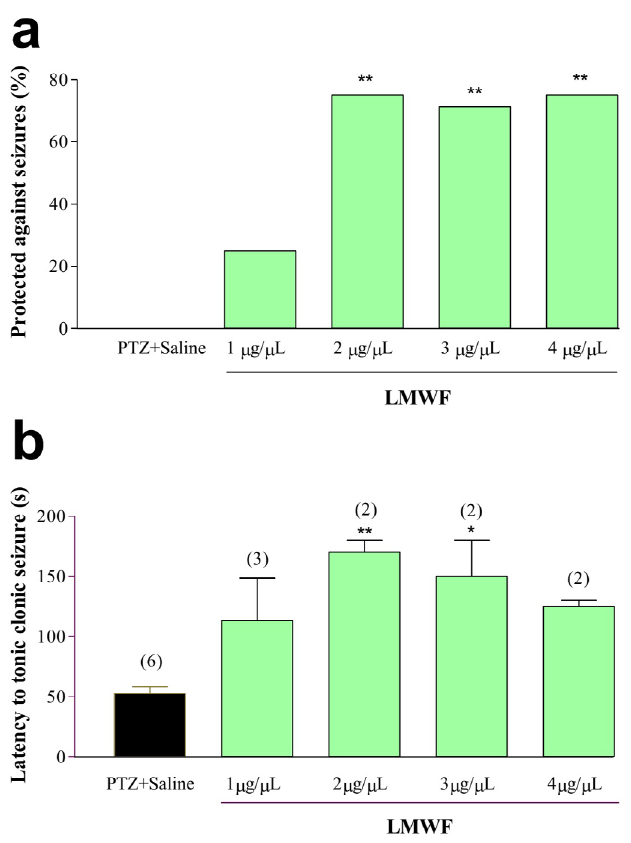
Figure 2. LMWF anticonvulsant activity in PTZ-induced seizure model. A: Percentages of animals protected against PTZ-induced seizures after injection of different concentrations of LMWF. The frequencies of protected animals were analyzed using the chi-square test, followed by Fischer’s test. *p <0.05 . ** p <0.01 compared to the control. B: Mean ± SEM of the latencies for triggering seizures in animals not protected against PTZ- induced seizures after injection of different concentrations of LMWF. Data were analyzed using one-way ANOVA followed by the Tukey post-test. *p <0.05 and **p <0.01 compared to the control. The numbers in parentheses above the columns represent the number of animals